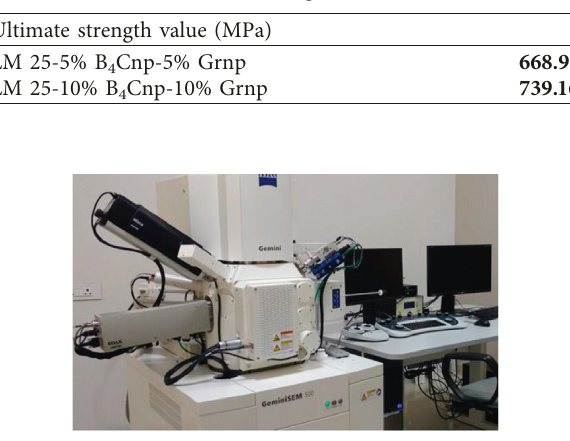
Figure 10: Field emission scanning electron microscopy